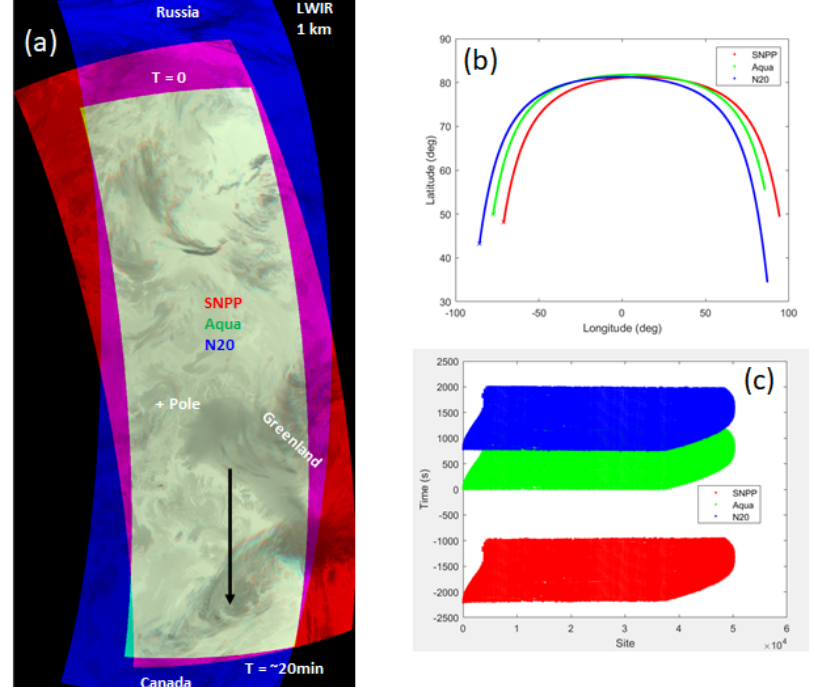
Figure 2. A tandem configuration is formed with MODIS-Aqua and the VIIRS on SNPP and N20. Panel ( a ) shows the overlapping Long-Wave IR (LWIR) imagery compositing MODIS band 31 with VIIRS band M15. Granule times are 1 October 2020 with SNPP starting 6:26Z, Aqua starting 7:05Z, and N20 starting 7:12Z. Panel ( b ) shows the satellite ground tracks and panel ( c ) shows the pixel times relative to 1 October 2020 7:05Z plotted by site number covering the full triple overlap.